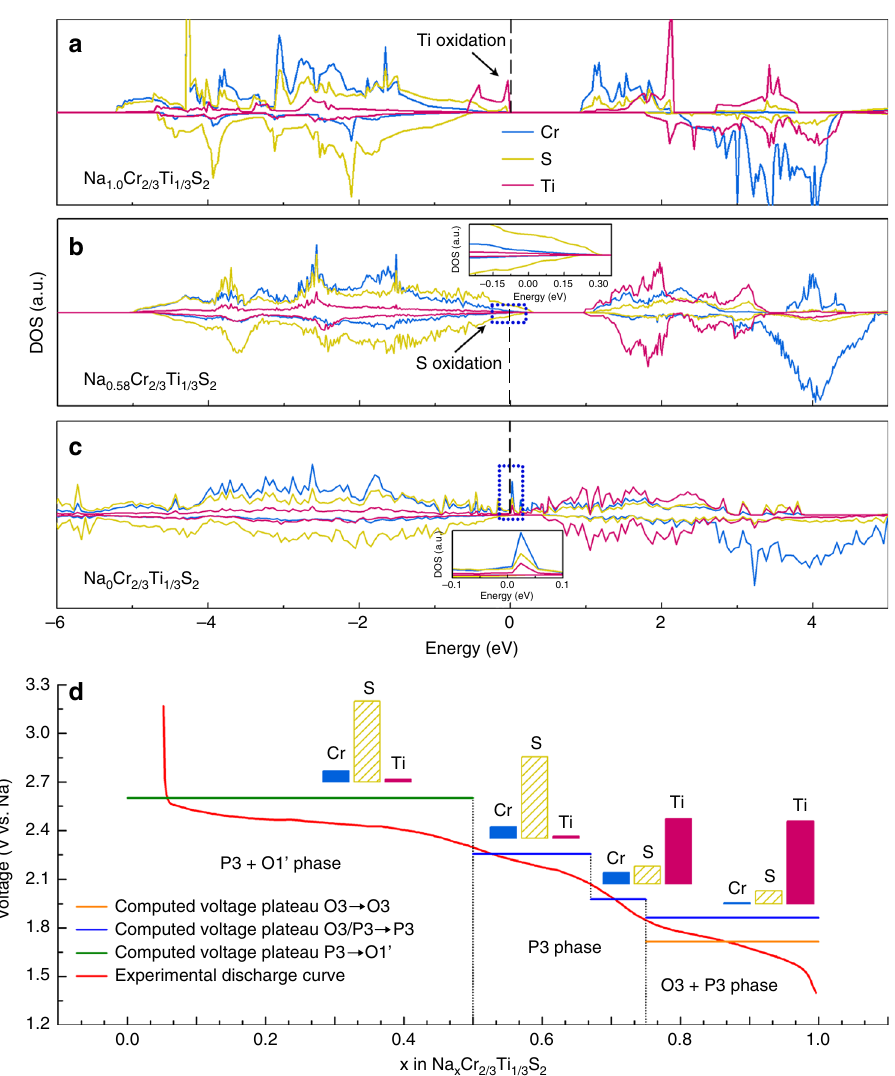
Fig. 6 Density of states and computed voltages. The DOS of a NaCr 2/3 Ti 1/3 S 2 , b Na 0.58 Cr 2/3 Ti 1/3 S 2 , and c Na 0 Cr 2/3 Ti 1/3 S 2 with the Fermi level marked using vertical dashed lines. d Calculated voltage platform comparing to experimental electrochemical curve. The columns above the platform are contribution of elements in the redox process, coming from integration of DOS in the range of − 0.1 to 0